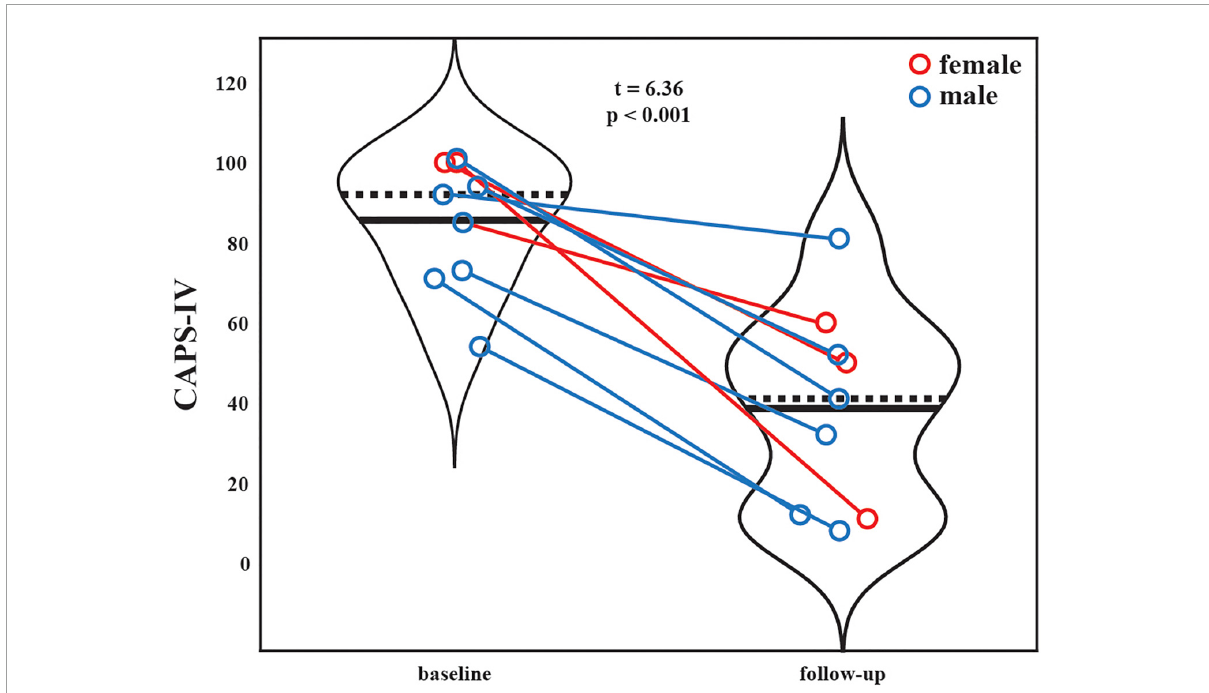
FIGURE2 Patient CAPS-IV total severity scores at the baseline (pre-therapy) and two-month follow-up (post-therapy) scanning sessions. Black solid and dashed lines indicate group means and medians, respectively. Blue marker = male. Red marker = female. A significant reduction is PTSD severity was observed after MDMA-AT (baseline > follow-up; N = 9, t = 6.36, p =